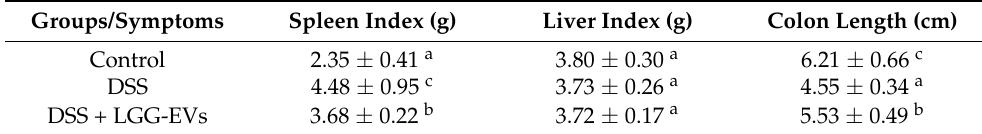
Table 2. The organ index and colon length were evaluated in different groups ( n = 7).